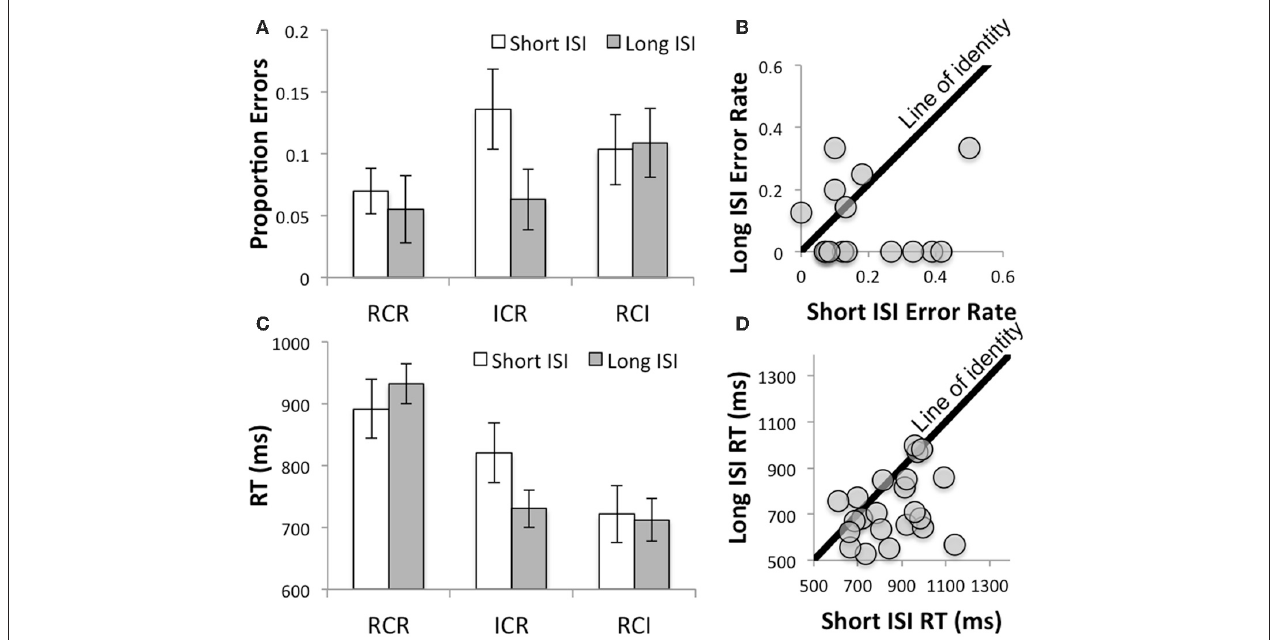
FIGURE 2 | Disproportionate benefits as a function of ISI in the ICR condition in terms of errors (A and B) and reaction times (C and D). (A) Error rates decreased as a function of ISI in the ICR condition. (B) The majority of the data fell reliably below the line of identity relating error rates on the short and long ISI trials in the ICR condition, indicating a reliable increase in accuracy as a function of ISI in that condition.